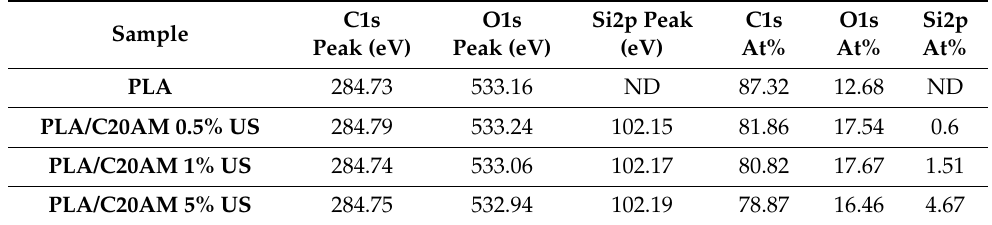
Table 4. XPS data in terms of binding energy and atomic percentage of the samples obtained.